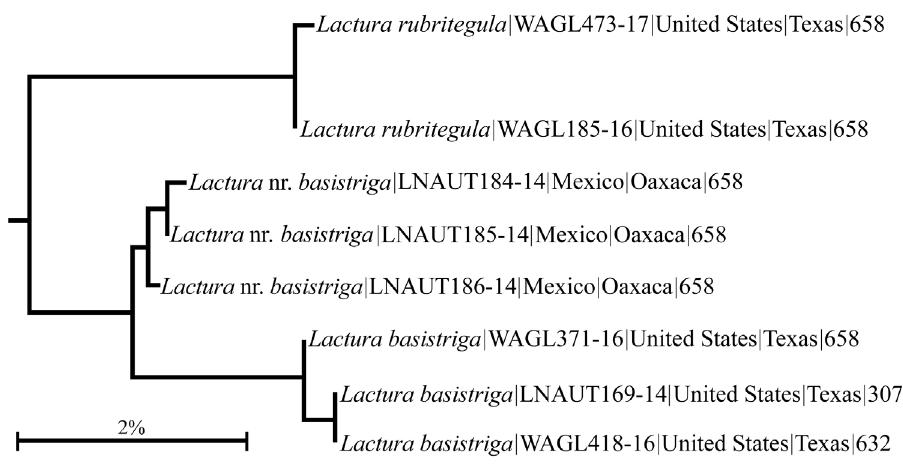
Figure 10. North American COI barcode tree for Lactura basistriga complex available as of 6 October 2017. Included for each taxon is the BOLD process ID, region, and sequence